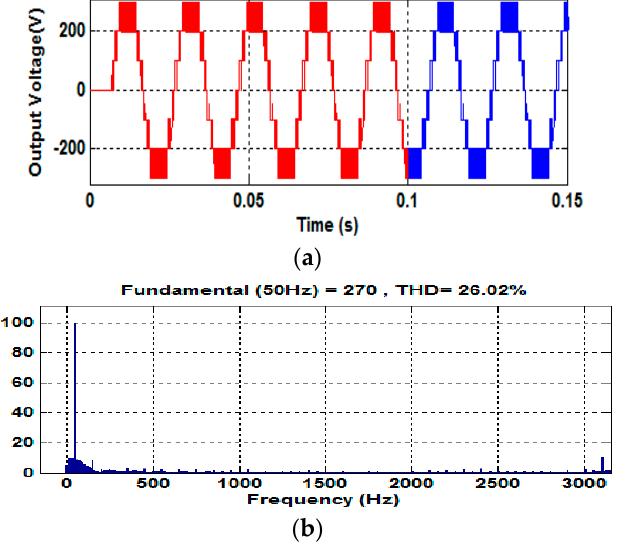
Figure 8. ( a ) Output voltage waveform of RVTMLI, and ( b ) harmonic spectrum analysis of RVTMLI output voltage.